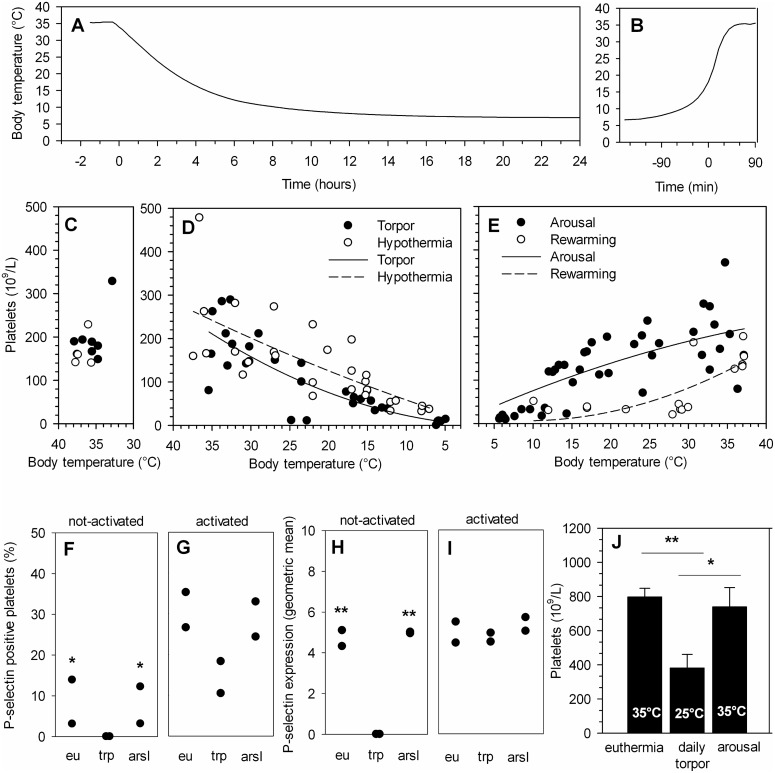
Body temperature dependent platelet count of functional platelets during torpor and arousal in natural hibernating Syrian hamster at 5°C ambient temperature.A) During spontaneous entrance into torpor body temperature gradually declines from 35°C to 8°C in a matter of hours. B) Increase in body temperature during a spontaneous arousal, demonstrating the rapid increase to euthermic level. Line represents one of thirty-one Syrian hamsters, measured with an intraperitoneal implanted Thermochron iButton. C) Normal platelet count in summer-euthermic Syrian hamster (n = 5, open dots; n = 7, black dots). D) Platelet count decreases with lower body temperature from euthermic stage to deep torpor in the Syrian hamster (n = 31), both during natural hibernation as well as during forced hypothermia (n = 8, multiple sampling). Curves from D) and E) are fitted to a polynomial quadratic curve with equation y = y0+ax+bx2 and constraints of y0>0 and y0≤ lowest platelet count for torpor. Black dots (•) are natural hibernating hamsters, open dots (°) are forced-cooled hamsters. E) Platelet number increases rapidly to a normal level during arousal (n = 42) or rewarming from forced hypothermia (n = 7, multiple sampling). F) P-selectin positive platelets are absent in torpid hamsters. G) The platelets are activatible following addition of ADP and the subsequent percentage of P-selectin positive platelets is similar to euthermic and aroused animals. H) The P-selectin expression level per platelet was significantly decreased in non-activated platelets from torpor compared to euthermia and arousal hamsters. I) Upon activation with ADP, P-selectin expression reaches similar levels in euthermia (eu), torpor (trp) and arousal (arsl). Please note that F-I are n = 2 per group. J) Circulating platelet count is reduced during daily torpor in the Djungarian hamster, and restored upon arousal. Bars represent mean ± SEM of 5 to 9 animals per group. *P<0.05, **P<0.01.